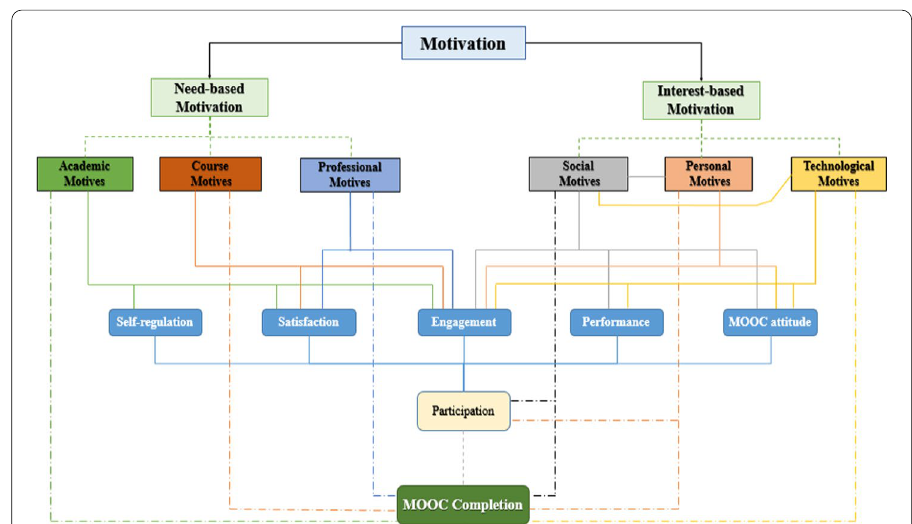
Fig. 4 Concept map of motivational factors’ effects on course completion in